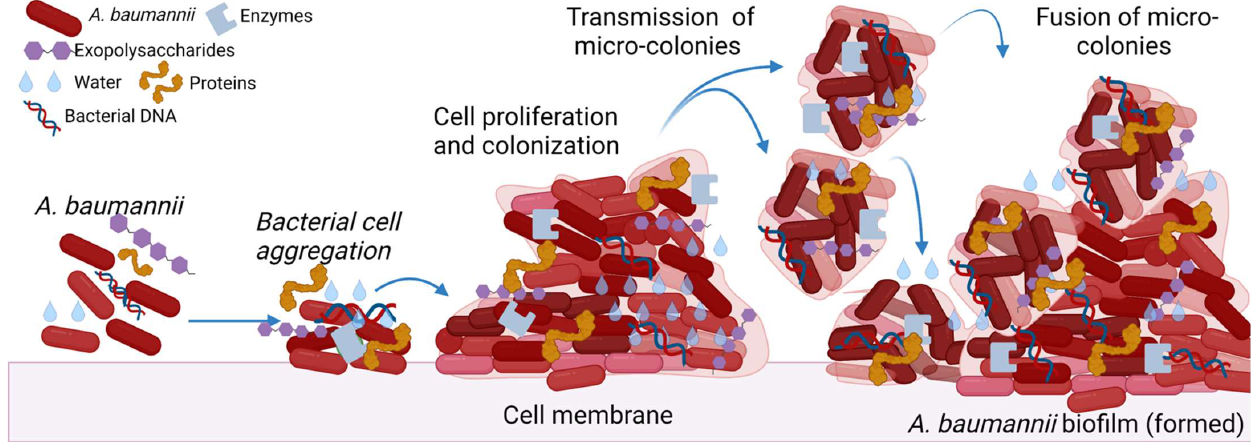
Figure 1. A. baumannii biofilm formation. The figure was made with www.biorender.com (accessed on: 25 July 2022).